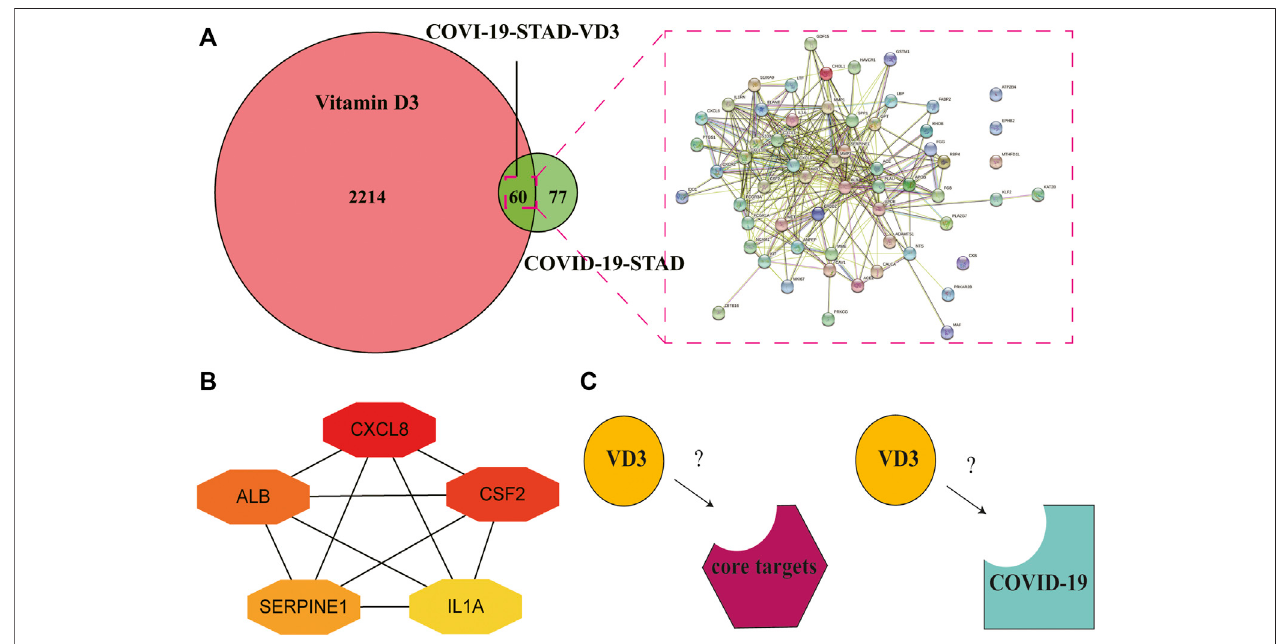
FIGURE5| Identi fi cationofcoretargetsofVD3againstSTADandCOVID-19. (A) STRINGanalysisofVD3andSTAD/COVID-19intersectinggenes. (B) Cytoscape analysisrepresentingthegeneinteractionnetworksassociatedwithVD3anti-STAD/COVID-19.Thetop fi vehubgenes — CXCL8 , CSF2 , ALB , SERPINE1 and IL1A — are highlighted. (C) Diagram of receptor and ligand (VD3 or